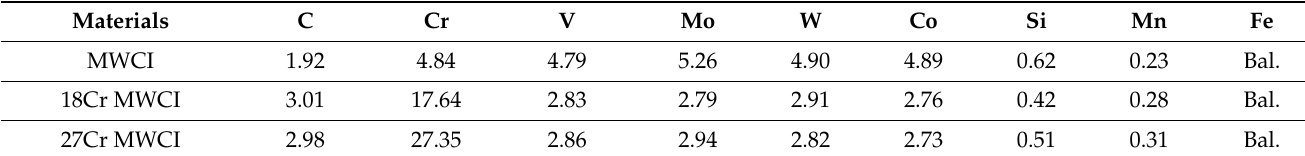
Table 1. Chemical compositions of each test piece (wt. %).